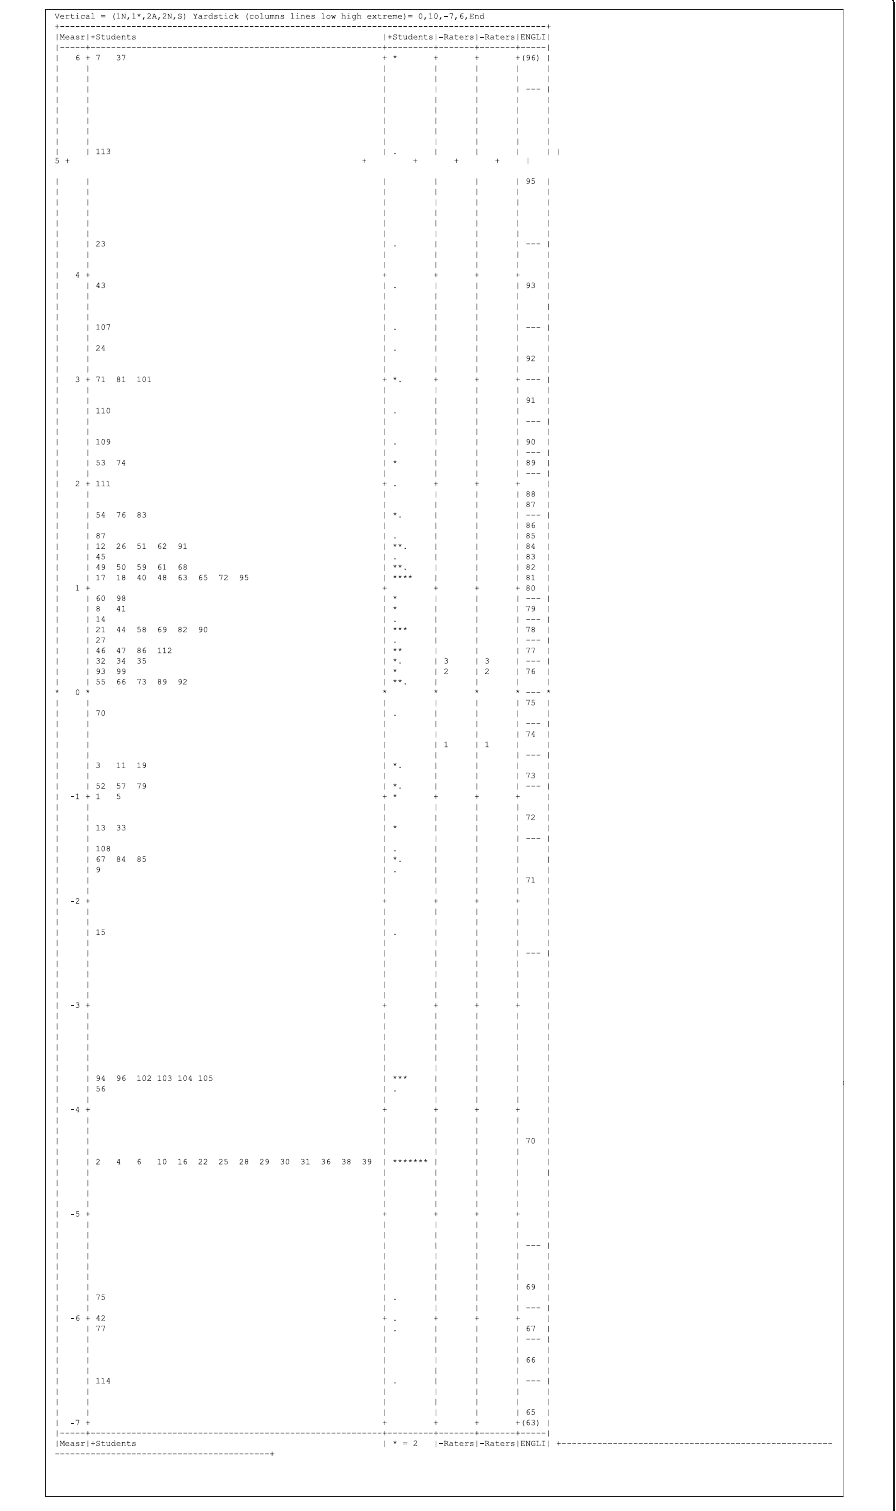
Fig. 1 Variable map (Table 6 on FACETS). Figure 1 displays every facet on a ruler-like variable map. The first column shows the logit scale on which each facet element is estimated. Second and fourth columns display student ability and rater severity measures